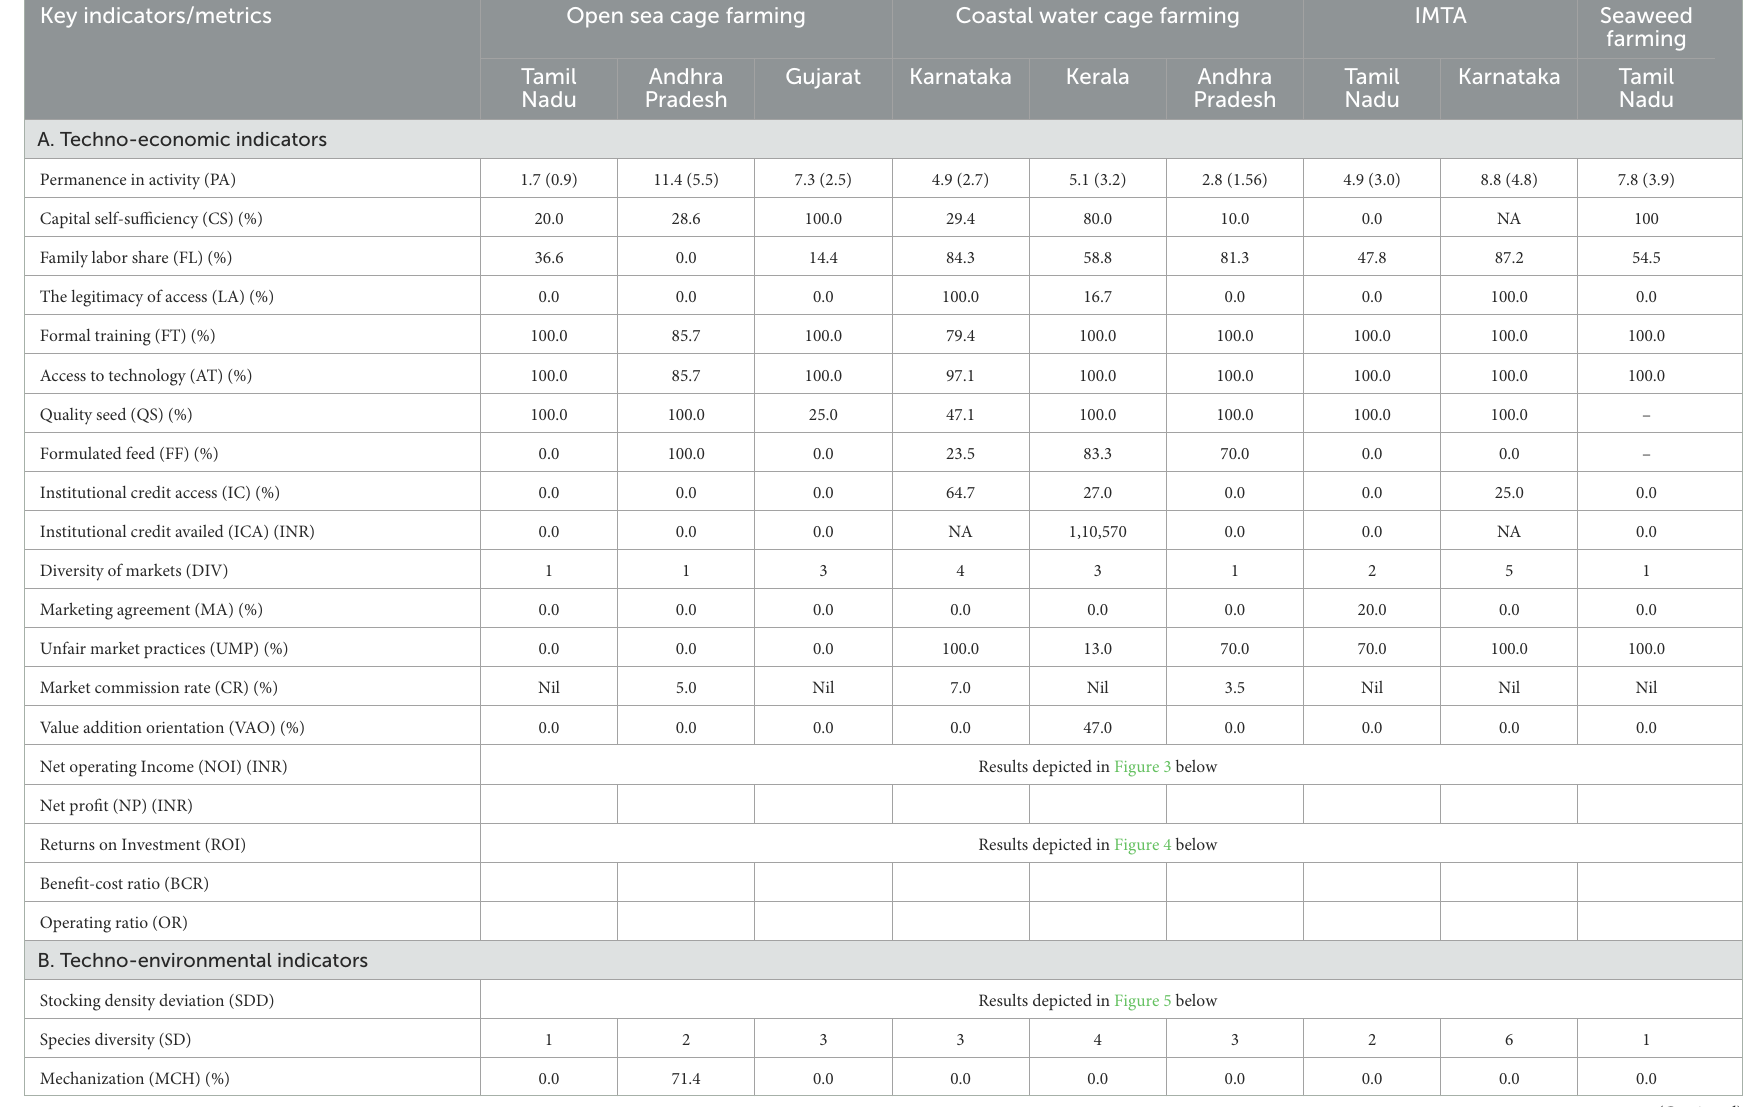
TABLE 4 Estimated sustainability indicators associated with selected mariculture enterprises in sample locations in India, 2022. Key